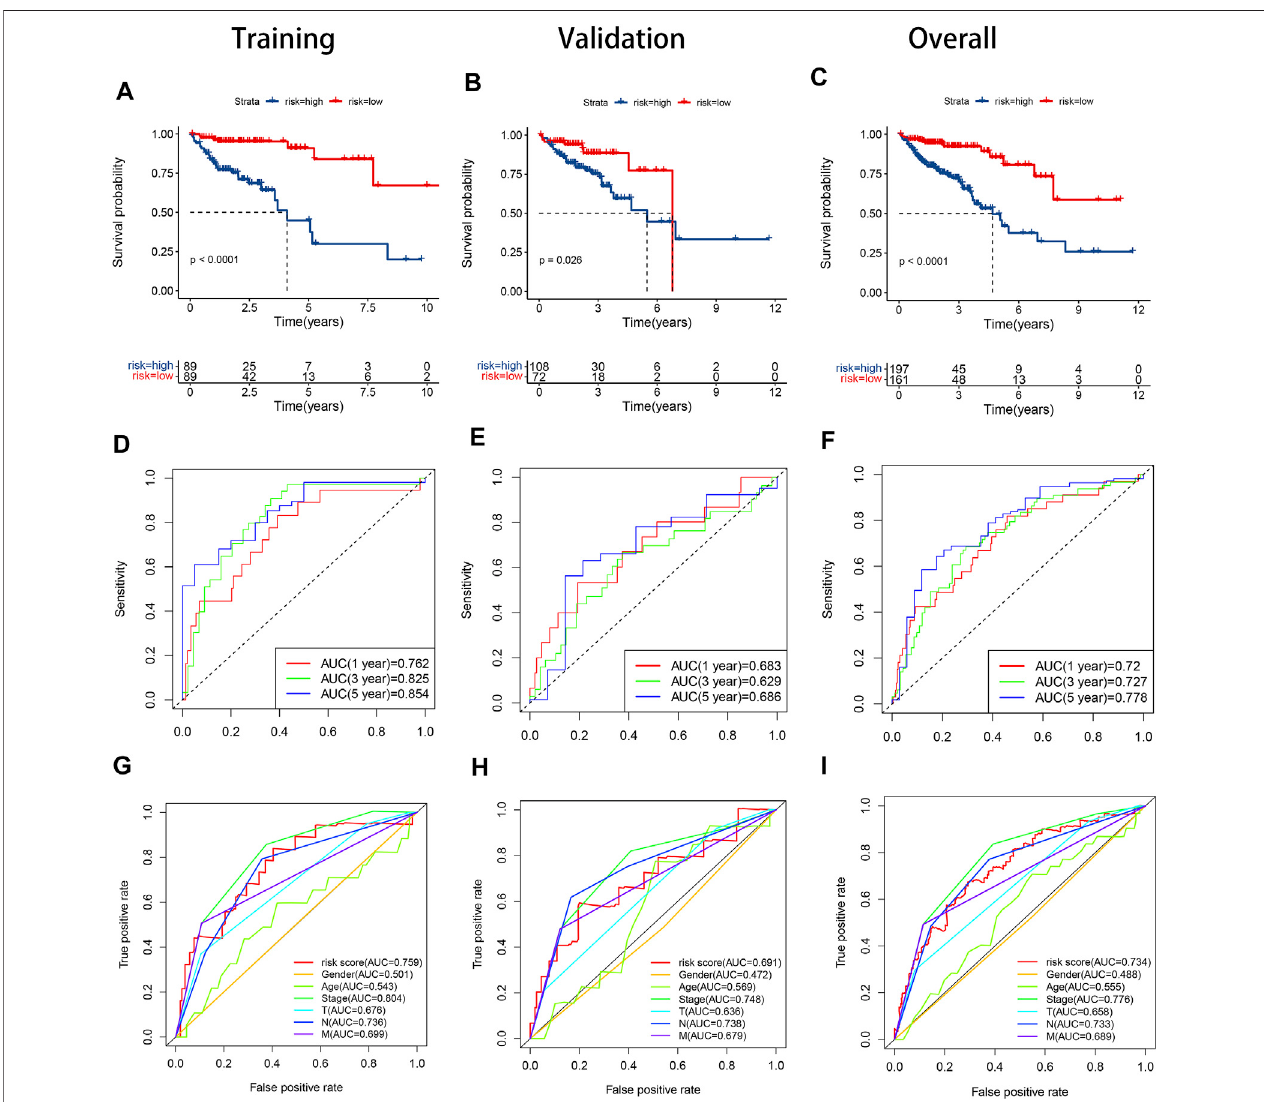
FIGURE 5 | KM curves, time-dependent ROC curves and clinical feature ROC curves in the training set, validation set and overall samples respectively. (A). KM curve in the training set; (B). KM curve in the validation set; (C). KM curve in the overall samples; (D). Time-dependent ROC curve in the validation set; (E). Time- dependent ROC curve in the validation set; (F). Time-dependent ROC curve in the validation set; (G). Clinical feature ROC curve in the overall samples; (H). Clinical feature ROC curve in the overall samples; (I). Clinical feature ROC curve in the overall samples.